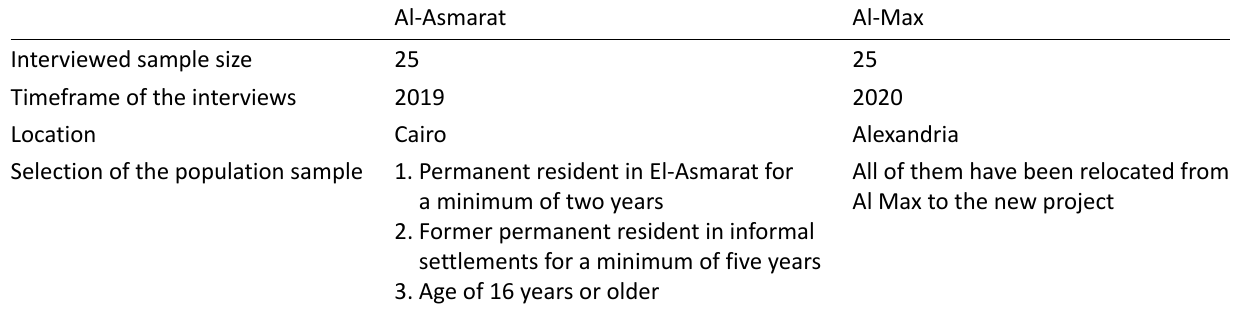
Table 2. Overview of